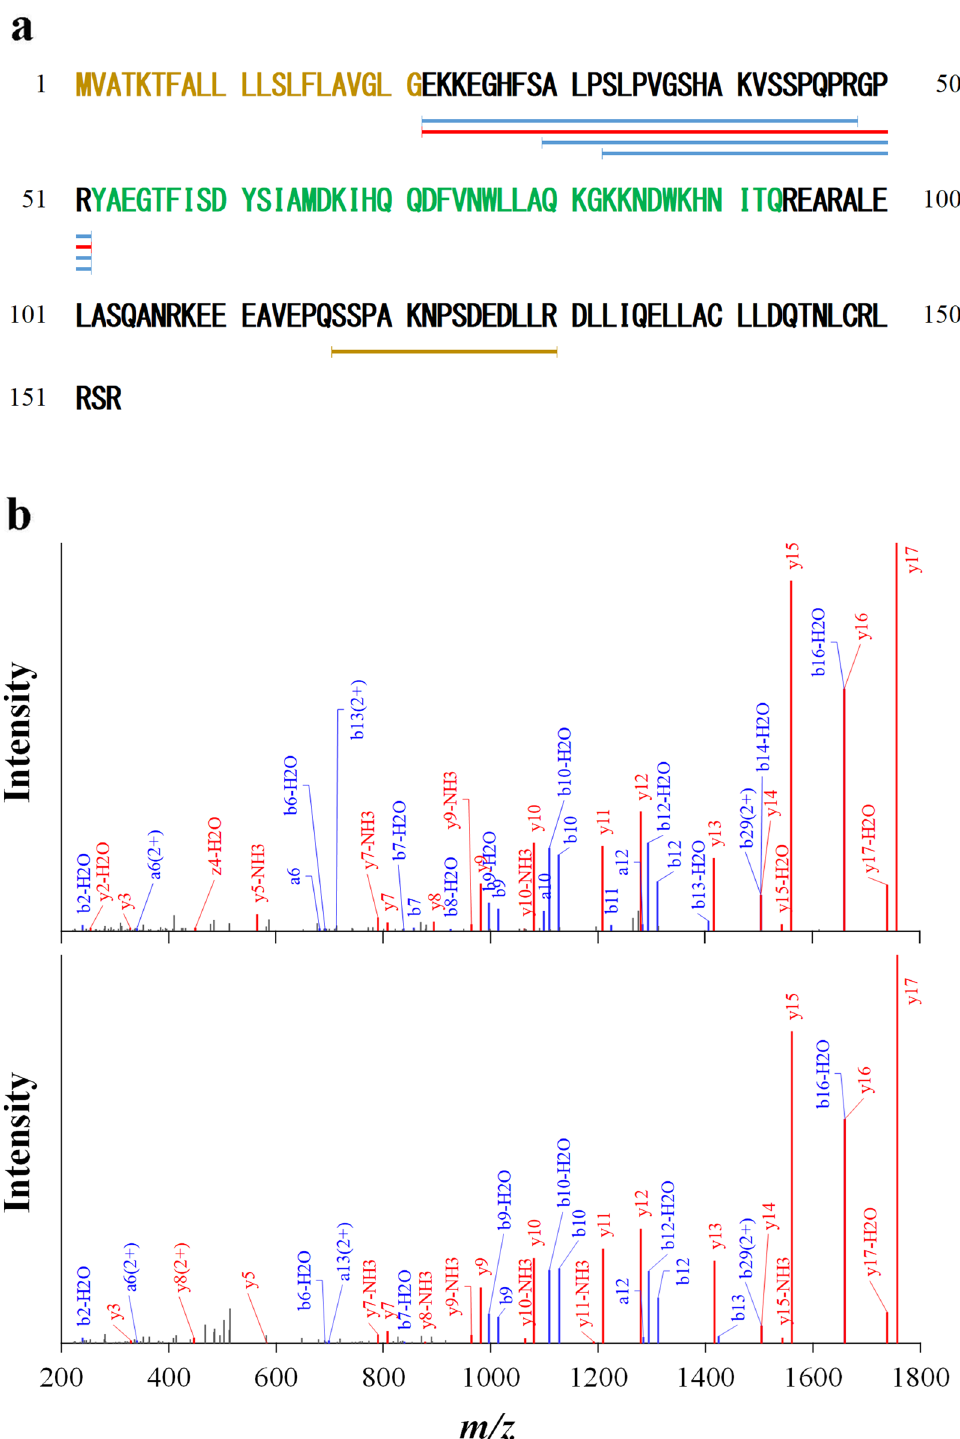
Figure 1. Peptidomic identification of proGIP-derived peptides from human plasma. ( a ) Sequence alignment of GIP_ HUMAN[22–51] (red horizontal line) and other cleaved products of proGIP identified with an FDR of 0% (blue horizontal lines) or 1% (yellow horizontal lines) by our peptidomic analysis. The predicted signal peptide of the preproprotein is shown in yellow letters and authentic GIP peptide in green letters, respectively. ( b ) Annotated MS/MS fragmentation spectra for plasma GIP_HUMAN[22–51] filtered by peptidomic analysis and comparisons with those of the corresponding synthetic GIP_HUMAN[22–51] peptides. MS/MS spectra with sequence assignments of fragment ions corresponding to synthetic GIP_HUMAN[22–51] “EKKEGHFSALPSLPVGSHAKVSSPQPRGPR” with a m/z 530.9565 ( z = 6; upper panel) are compared with those of endogenous peptides (lower panel) to confirm the putative identification. The lower panel shows the MS/MS spectrum obtained by LC–MS/MS analysis in Fig. 5b with a retention time of 10.82 min. MS/MS spectra were deconvoluted into singly charged ions from the observed spectra and peaks were assigned theoretical m/z values for fragment ions. The annotations of the identified matched N-terminal-containing ions are shown in blue and the C-terminal-containing ions in red. The m/z differences between theoretical and observed values for most assigned peaks were less than 0.01